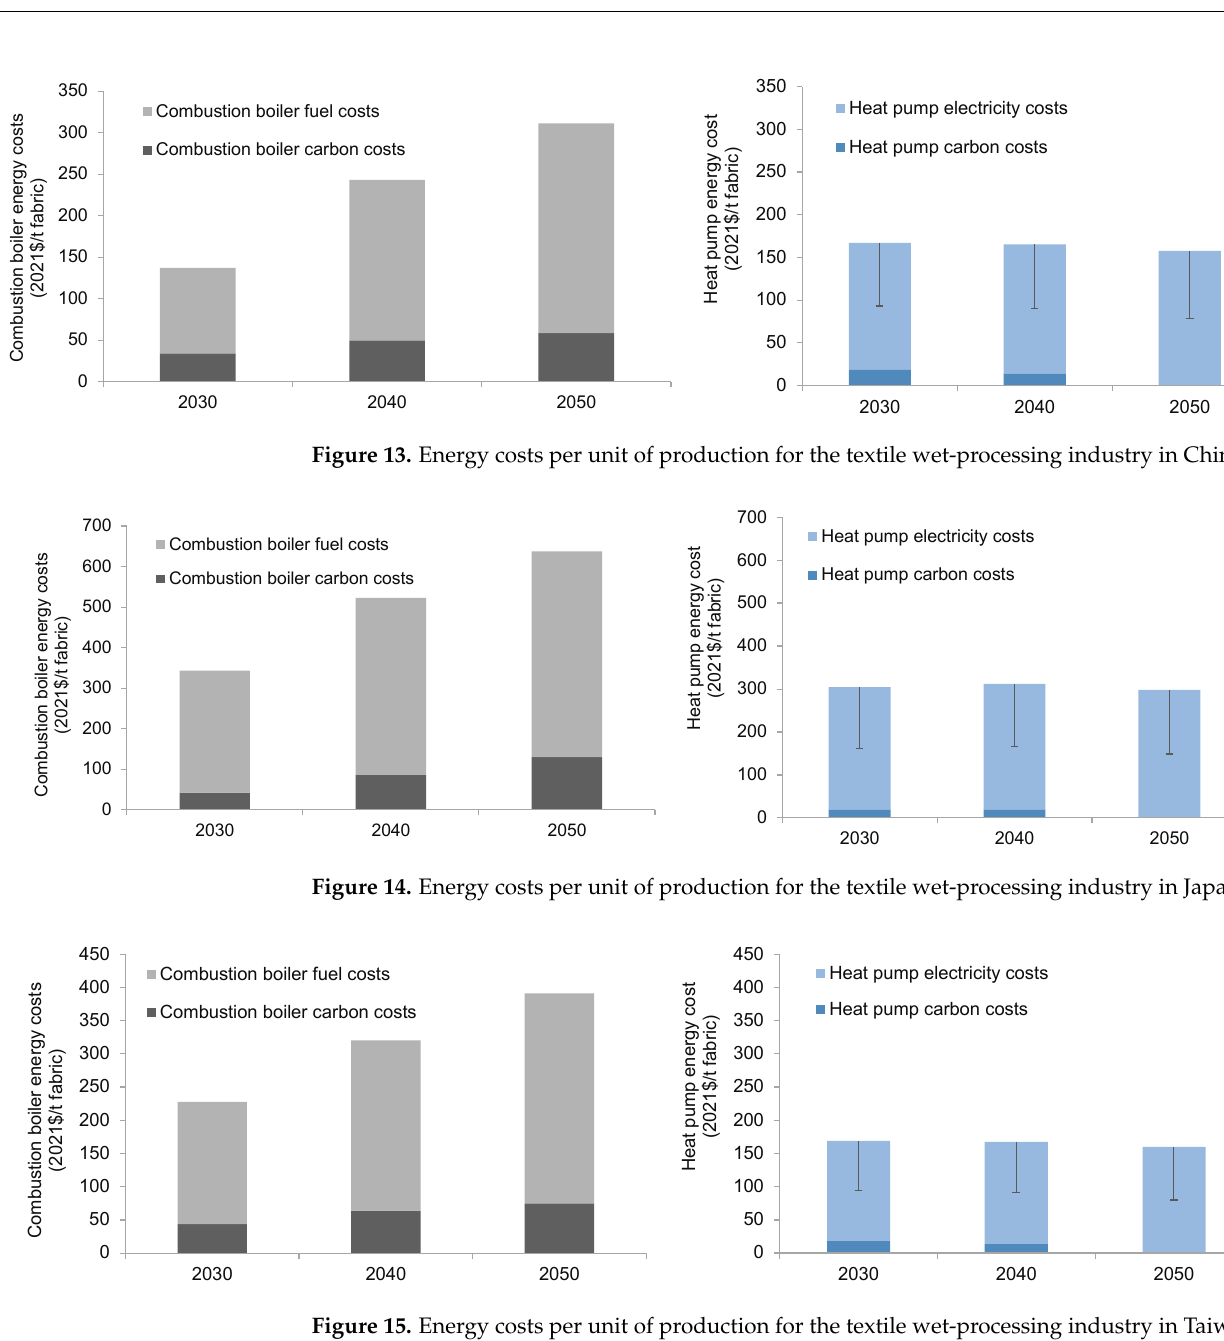
Figure 15. Energy costs per unit of production for the textile wet-processing industry in Taiwan.